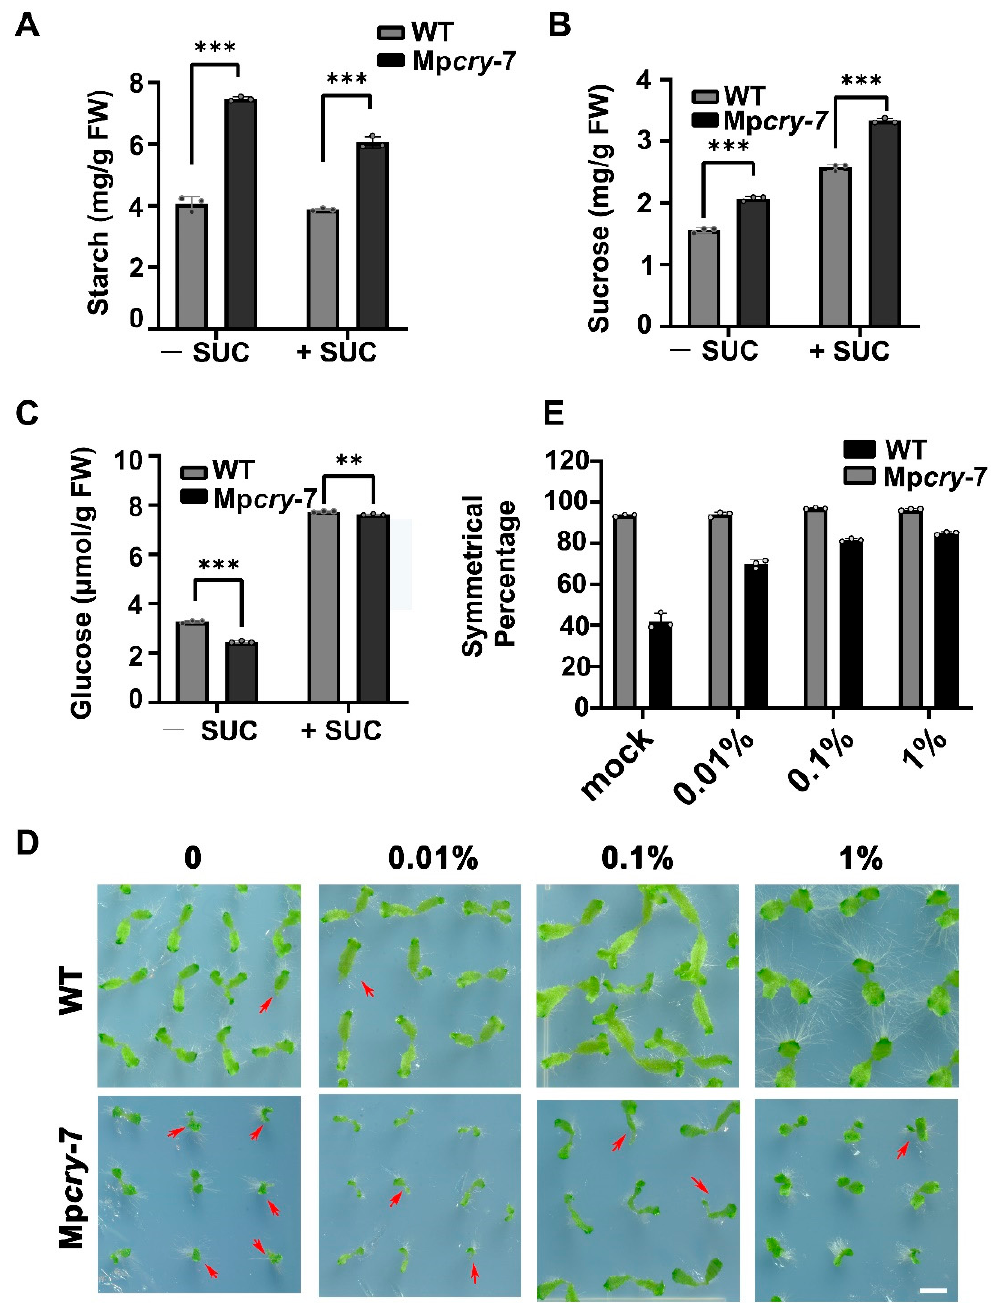
Figure 6. Mpcry regulates the symmetric growth of thalli by affecting glucose content under BL. ( A – C ) Quantifications of starch, sucrose, glucose contents in WT and Mp cry-7 grown under continuous BL for 14 days. Data are presented as mean ± SD ( n = 3 biological replicates). Student’s t test: *** p < 0.001, ** p < 0.01. ( D ) Photographs of gemmalings treated with different concentrations of glucose under BL (30 µ mol m − 2 s − 1 ) for 14 days. Bar = 5 mm. The red arrows represent individuals with asymmetric growth of thalli. ( E ) The percentage of individuals with symmetric growth of thalli in ( D ). Data are presented as mean ± SD ( n = 3 biological statistics). More than 100 gemmalings were used for one